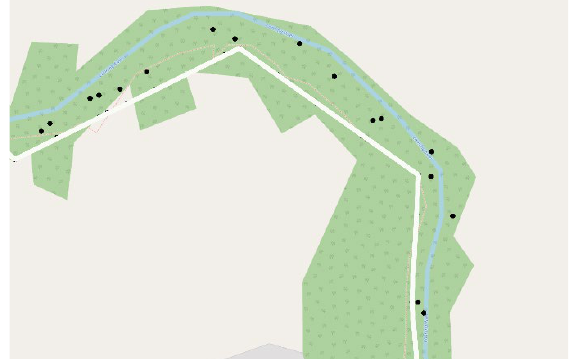
Figure 6: Section of the geo-located river points (black dotes) on